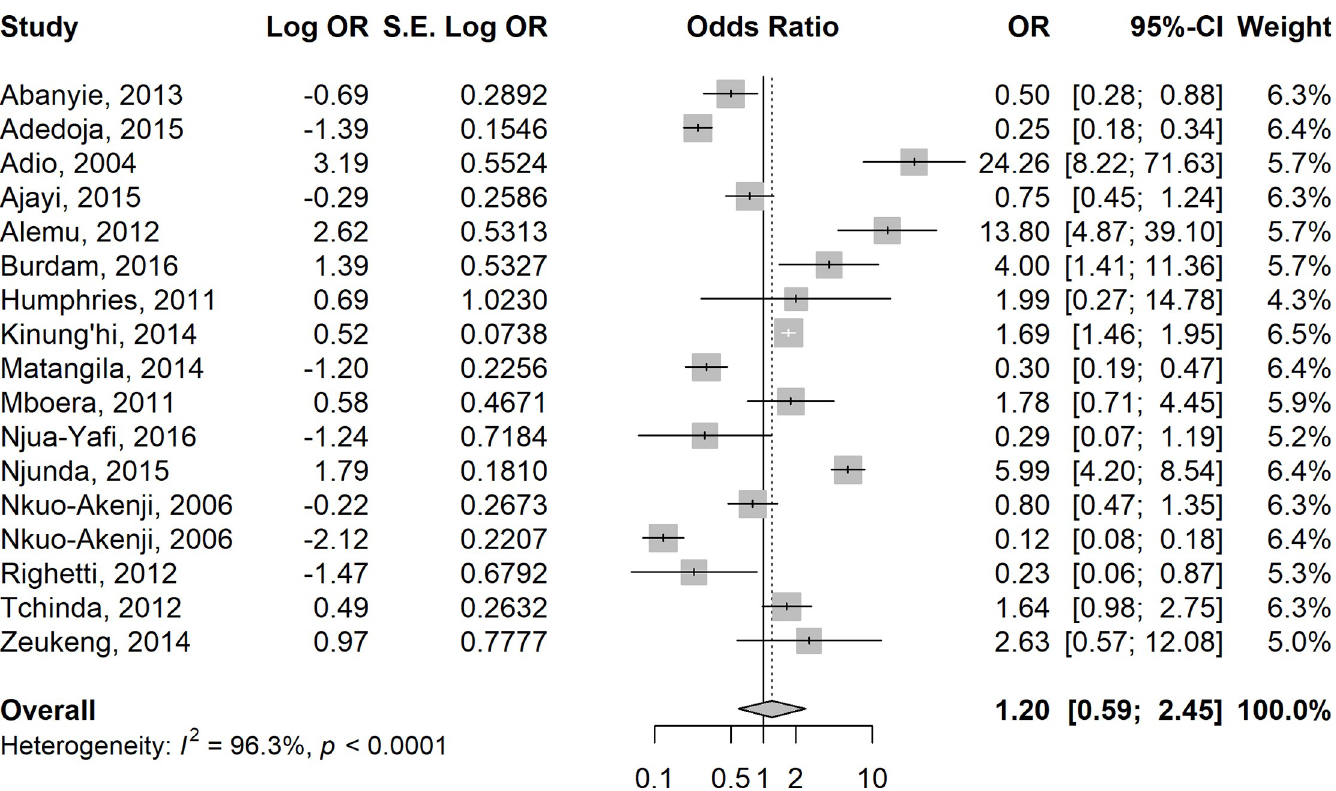
Fig 6. Forest plot showing odds of anaemia in children co-infected with Plasmodium species and pooled STH species compared with those who were infected with P . falciparum alone.